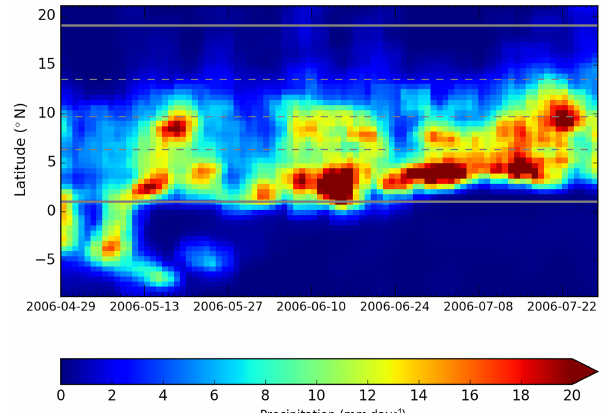
Figure 2. Time–latitude average (Hovmöller) of precipitation (mmday − 1 ). Precipitation is averaged between 8.5 ◦ W and 8.5 ◦ E in longitude. Day-to-day variability is eliminated by applying a moving average of ± 2 days. Due to the longitudinal average, the coastline is between 5 and 6 ◦ N. The two gray lines show the lati- tudinal extend of the regional model domain. The three dash gray lines represent the latitudes of the three locations studied (Cotonou, Djougou and